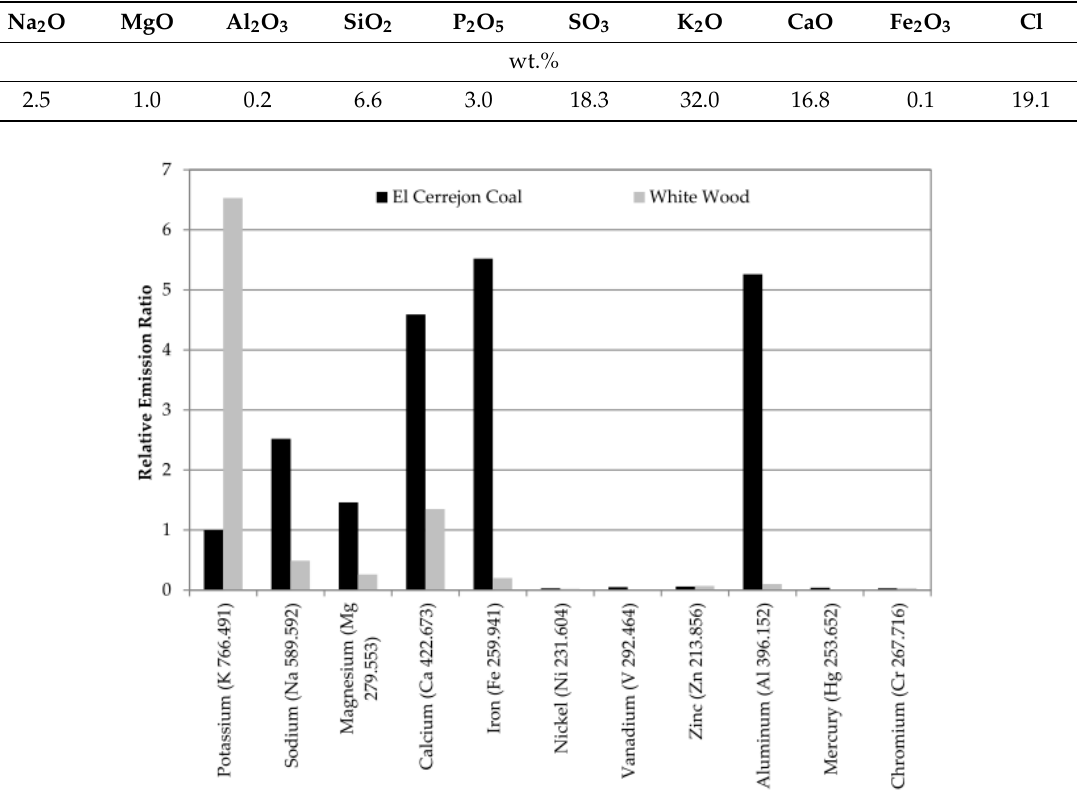
Table 1. The elemental composition of fly ashes (wt.%) from the combustion of commercial biomass (miscanthus straw). Adapted from Reference [7].